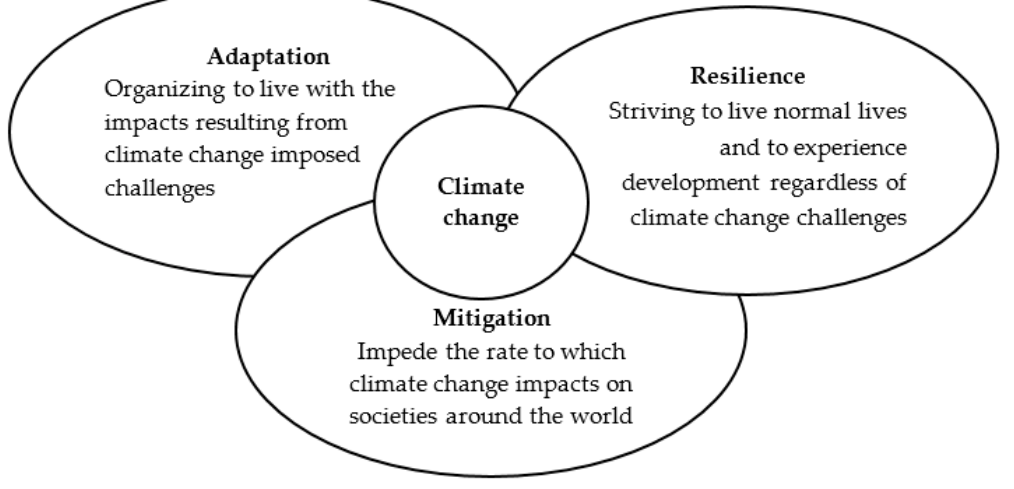
Figure 1. Three pillars of our warming climate (modified from 23rd Conference of the Parties (CoP) of the United Nation Framework Convention on Climate Change (UNFCCC) [5]).